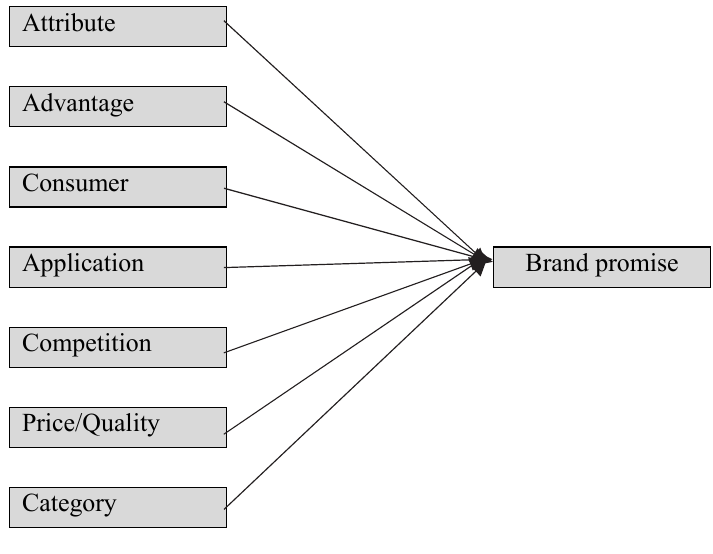
Fig. 2. The structure of different strategies on brand promise